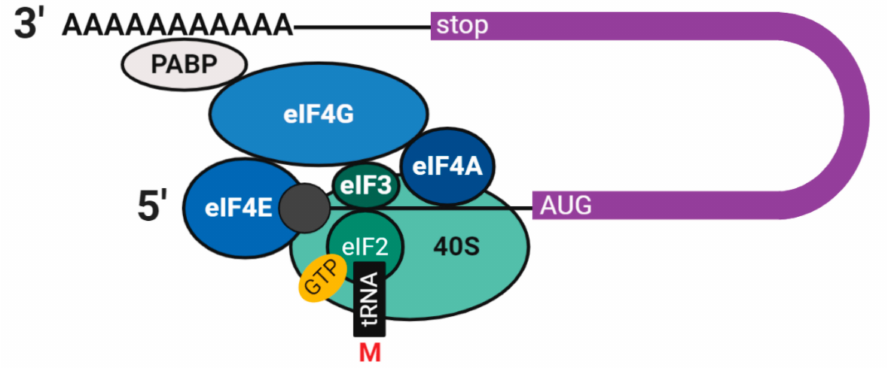
Figure 2. Translation initiation in eukaryotes. The closed-loop, cap-dependent translation initiation model. Proteins in shades of green form the 43S complex and in blue the eIF4F complex. eIF: Eukaryotic translation initiation factor, PABP: Poly(A) binding protein, M: Methionine, GTP: Guanosine-5 (cid:48) -triphosphate.